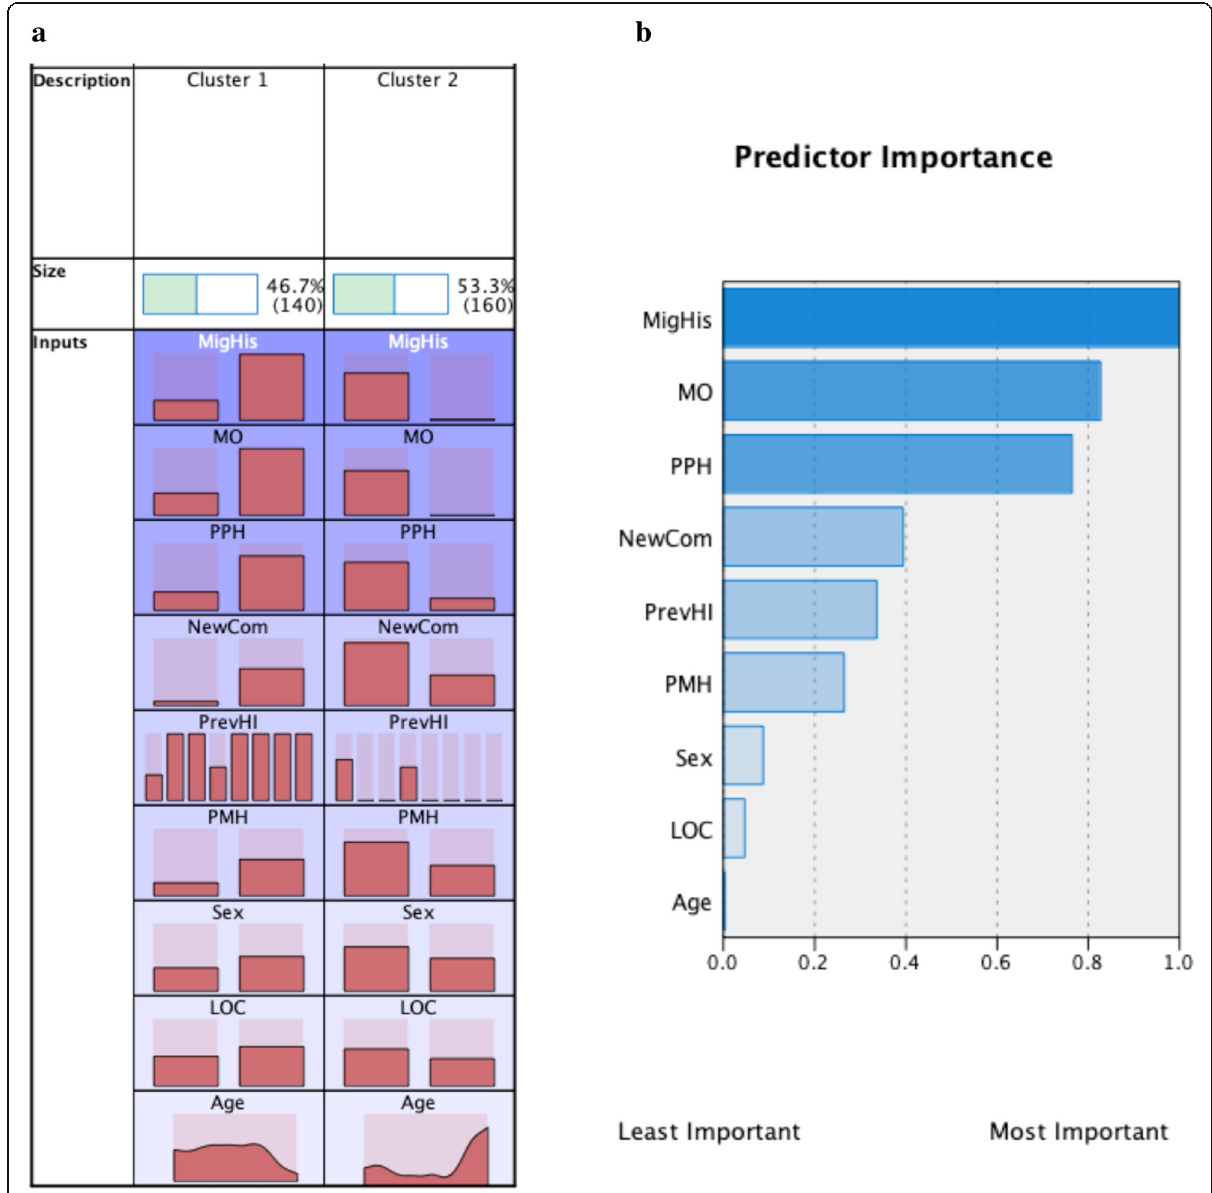
Fig. 1 PTH clusters. Two PTH clusters were identified ( a ). Cluster 1 contained 140 (46.7%) patients and 160 (53.7%) patients assembled in Cluster 2 ( a ). One hundred and six (76%) Cluster 1 patients had persistent PTH while 133 (83%) of Cluster 2 patients had acute PTH. Compared to Cluster 2 patients, Cluster 1 PTH patients had higher prevalence of a history of migraine (MigHis), medication overuse (MO), pre-existing psychological history (PPH), new PTH-associated comorbidities (NewCom), history of repeated head injuries (PrevHI) compared to Cluster 2 PTH patients ( a ). The top 3 important predictors were a history of migraine, higher level of medication overuse and pre-existing psychological history ( b ). The bars in a show relative distribution of the different clinical variables - with the right bar in each cluster representing present clinical variable while the left bar is for absent variable. For example, the first row for history of migraine (MigHis) shows that Cluster 1 had relatively higher prevalence compared to Cluster 2. The seven bars in previous head injury (PrevHI) represent frequency of head injuries ranging from 0 (left) to 7 (right) under each cluster; there were more patients with more frequent head injuries in Cluster 1 compared to Cluster 2. Age distribution is shown ranging from 18 (left) to 90 (right) years. For sex, left bars represent males while right bars represent